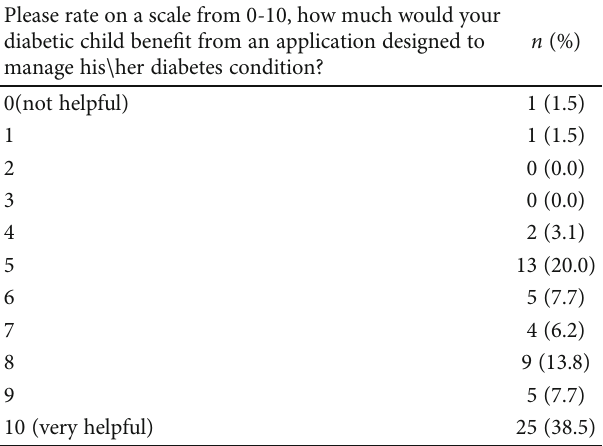
Table 4: Level of utility of the application ( n = 65